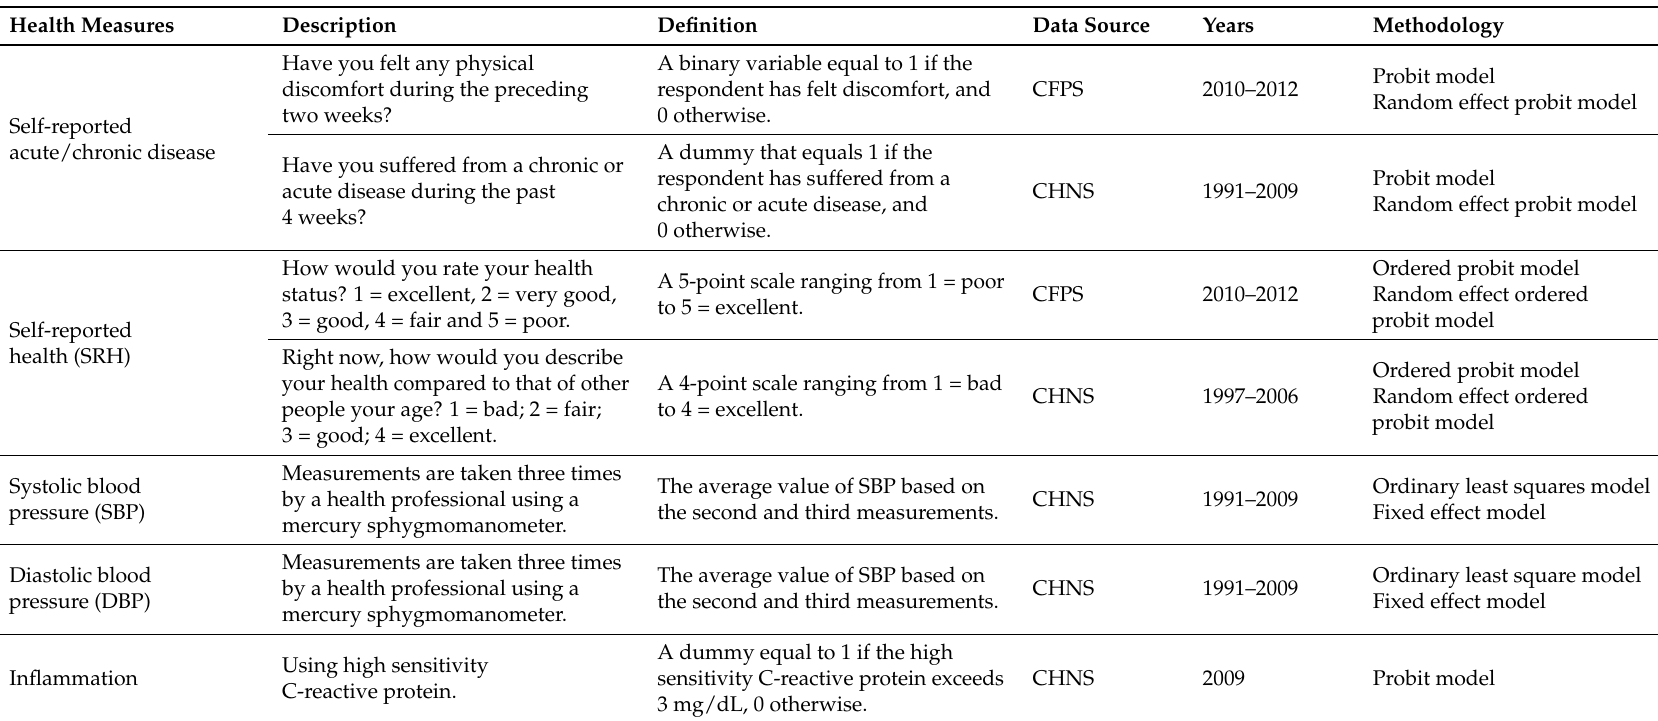
Table A2. Summary of health measures, data and